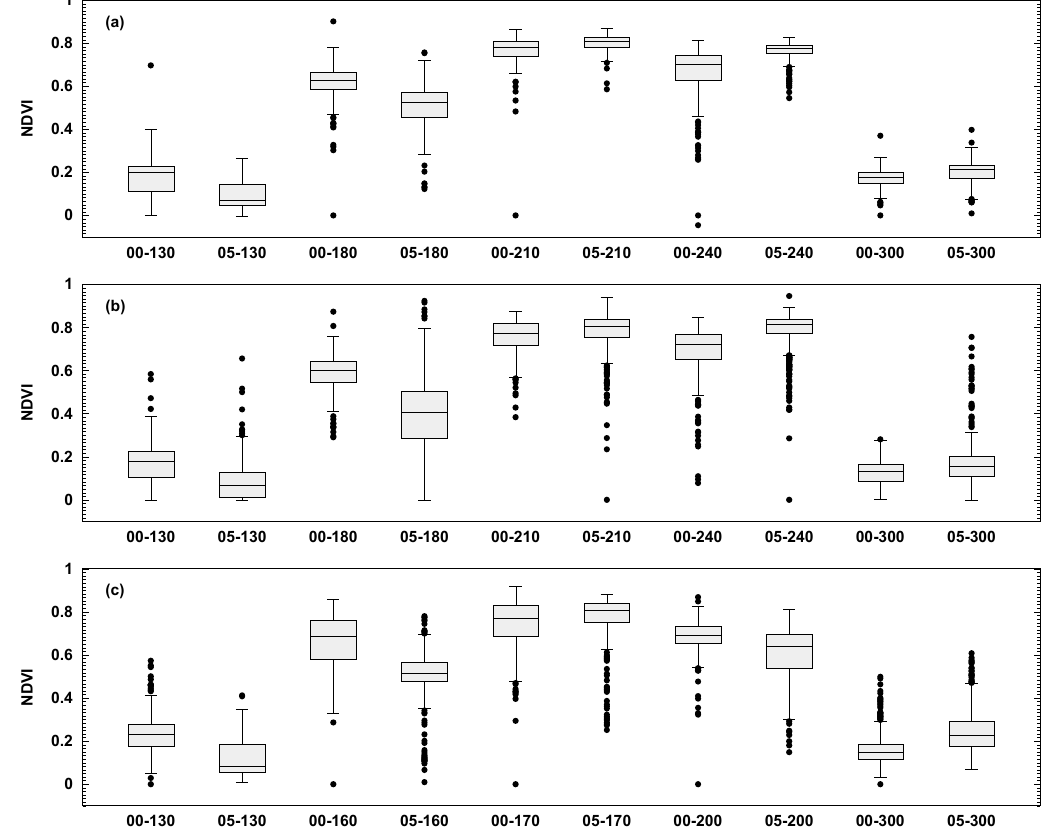
Figure 5. Boxplot of five selected time periods in the phenological cycle for corn/maize ( a ), soybeans ( b ), and spring wheat ( c ). In the x-axis, the first number represents the year (00 = 2000 and 05 = 2005) and second number day of the year.